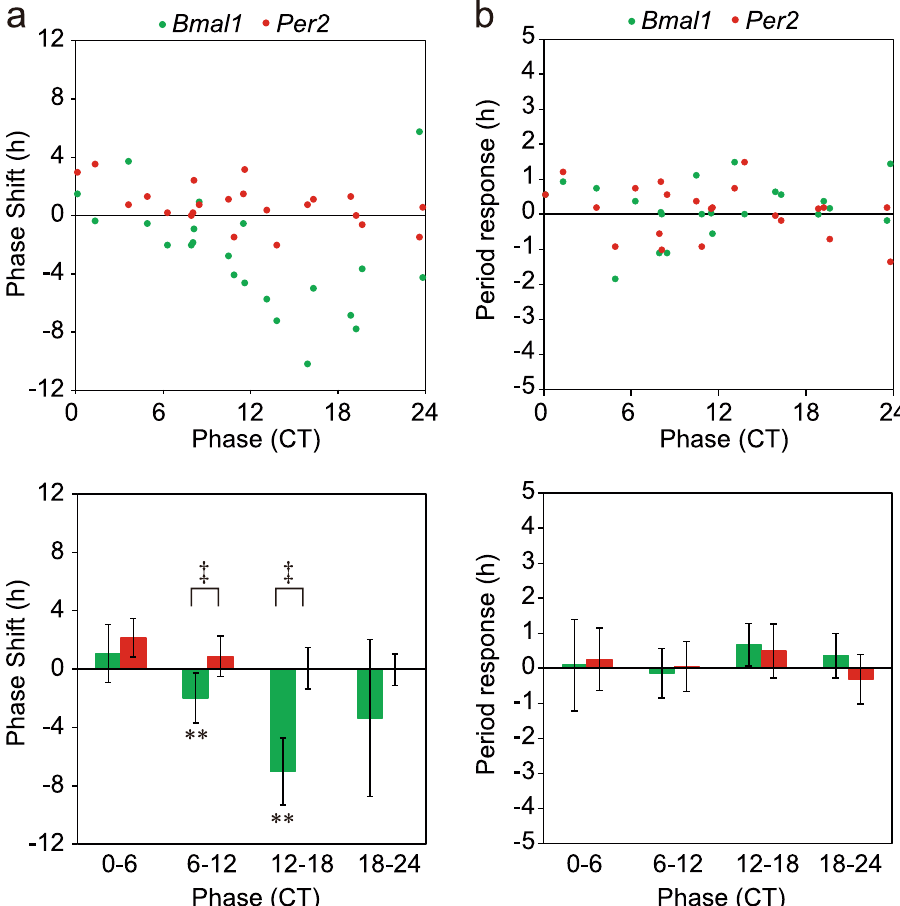
Figure 4. Phase-response curve and period-response curve for medium exchange of circadian Bmal1 and Per2 rhythms in the neonatal SCN ( a ) Phase-responses in individual slices (n = 22) of circadian Bmal1 (green circle) and Per2 (red circle) rhythms in the neonatal SCN (upper). The abscissa indicates the circadian phase in CT, where CT1 is the peak phase of Bmal1 rhythm and the ordinate indicates phase-shifts in hours with a positive sign for phase-advance shifts and with a negative for phase-delay. Mean phase-shifts with SD at CT0–CT6 (n = 5), CT6–CT12 (n = 9), CT12–CT18 (n = 4) and CT18–CT20 (n = 5) (lower). A significant phase-shift is indicated with asterisk ( * ) and a significant difference between the phase-shifts of two circadian rhythms is shown with dagger ( † ). ** p < 0.01 (one-way repeated measure ANOVA), ‡ p < 0.01 (two-way repeated measure ANOVA with post hoc Tukey-Kramer test). ( b ) Period-responses obtained from the same experiment as ( a ). Period-responses in individual slices of circadian Bmal1 (green circle) and Per2 (red circle) (upper), and the mean responses with SD at the 4 circadian phases